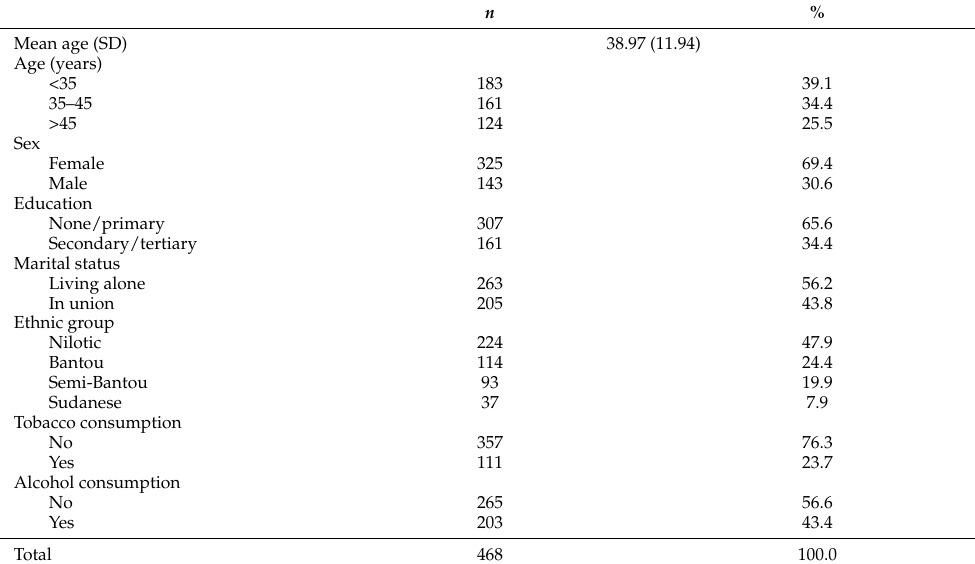
Table 1. Baseline sociodemographic characteristics ( n = 468).